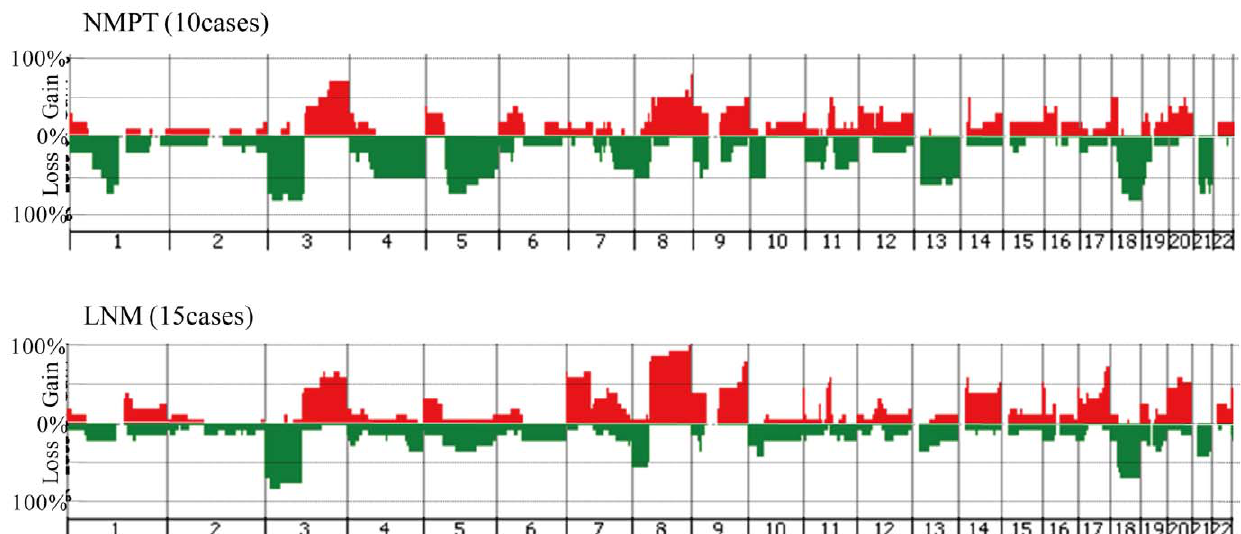
Figure 6. Genome-wide frequencies of CNAs in 10 NMPTs and 15 LNMs. Horizontal lines: oligonucleotide probes are shown in order from chromosomes 1 to 22. Within each chromosome, clones are shown in order from the p telomere to the q telomere. Vertical lines: frequency (%) of gains (positive axis) and losses (negative axis) are shown for each probe.